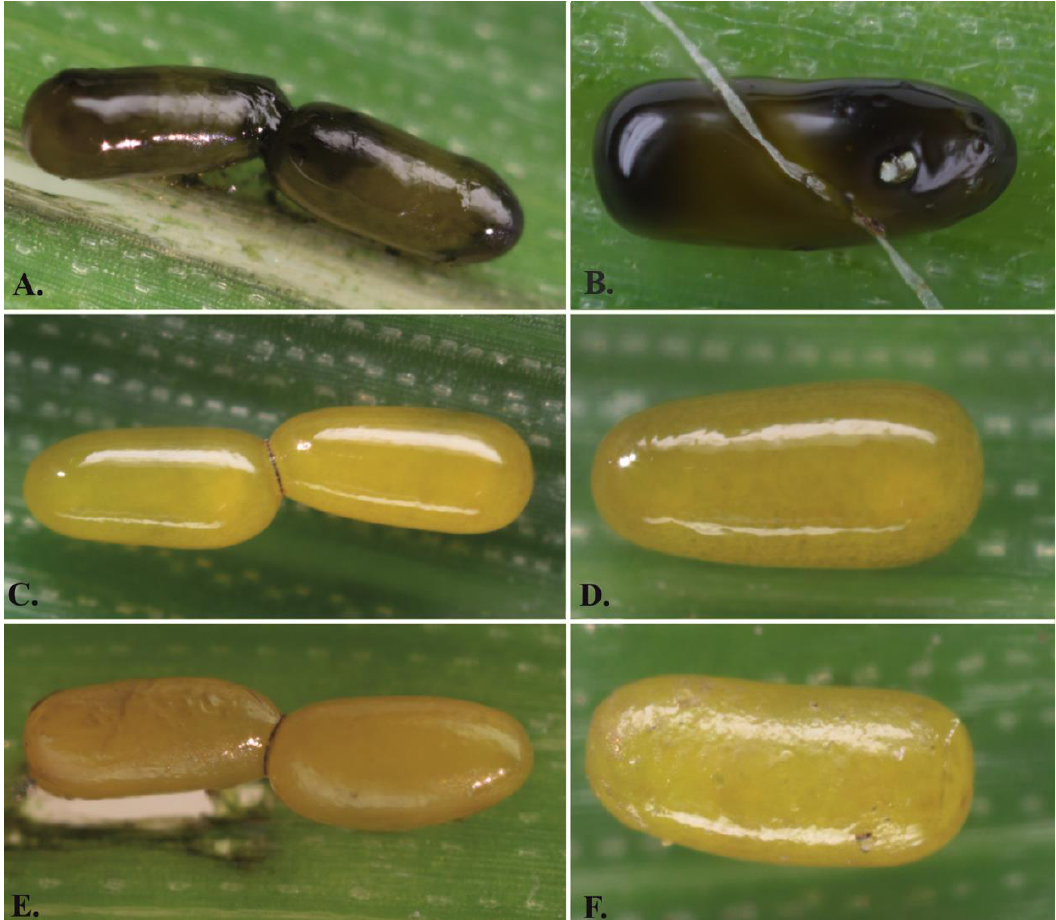
Figure 1. Three types of Oulema eggs: ( A , B ) sticky dark eggs (distinctive dark color; sticky layer); ( C , D ) little sticky eggs (yellow color; the structure of the egg surface is not visible under the sticky surface); ( E , F ) non-sticky eggs (yellow color; the structure of the egg surface is visible). Host eggs were not older than 24 h.